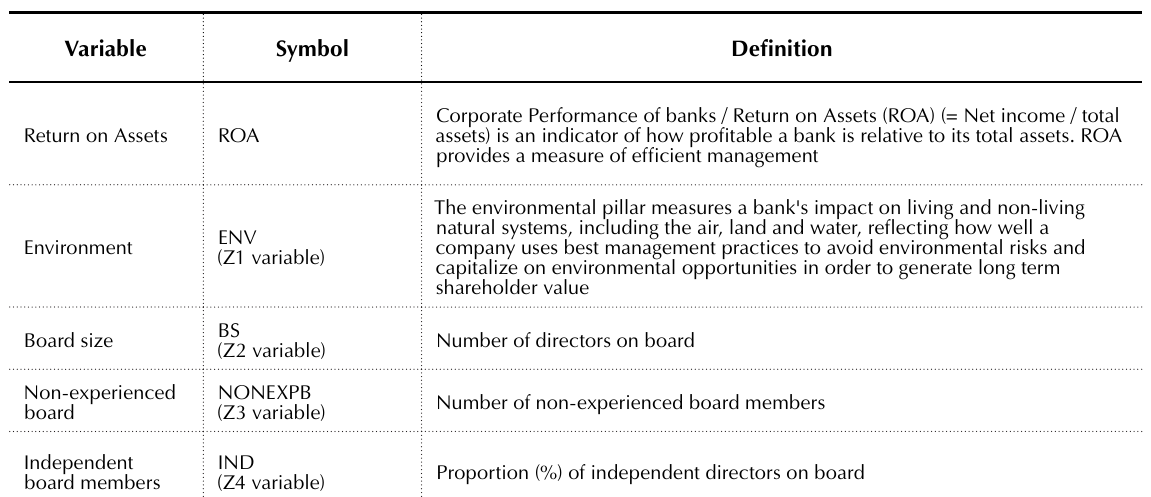
Table 1. Proposed